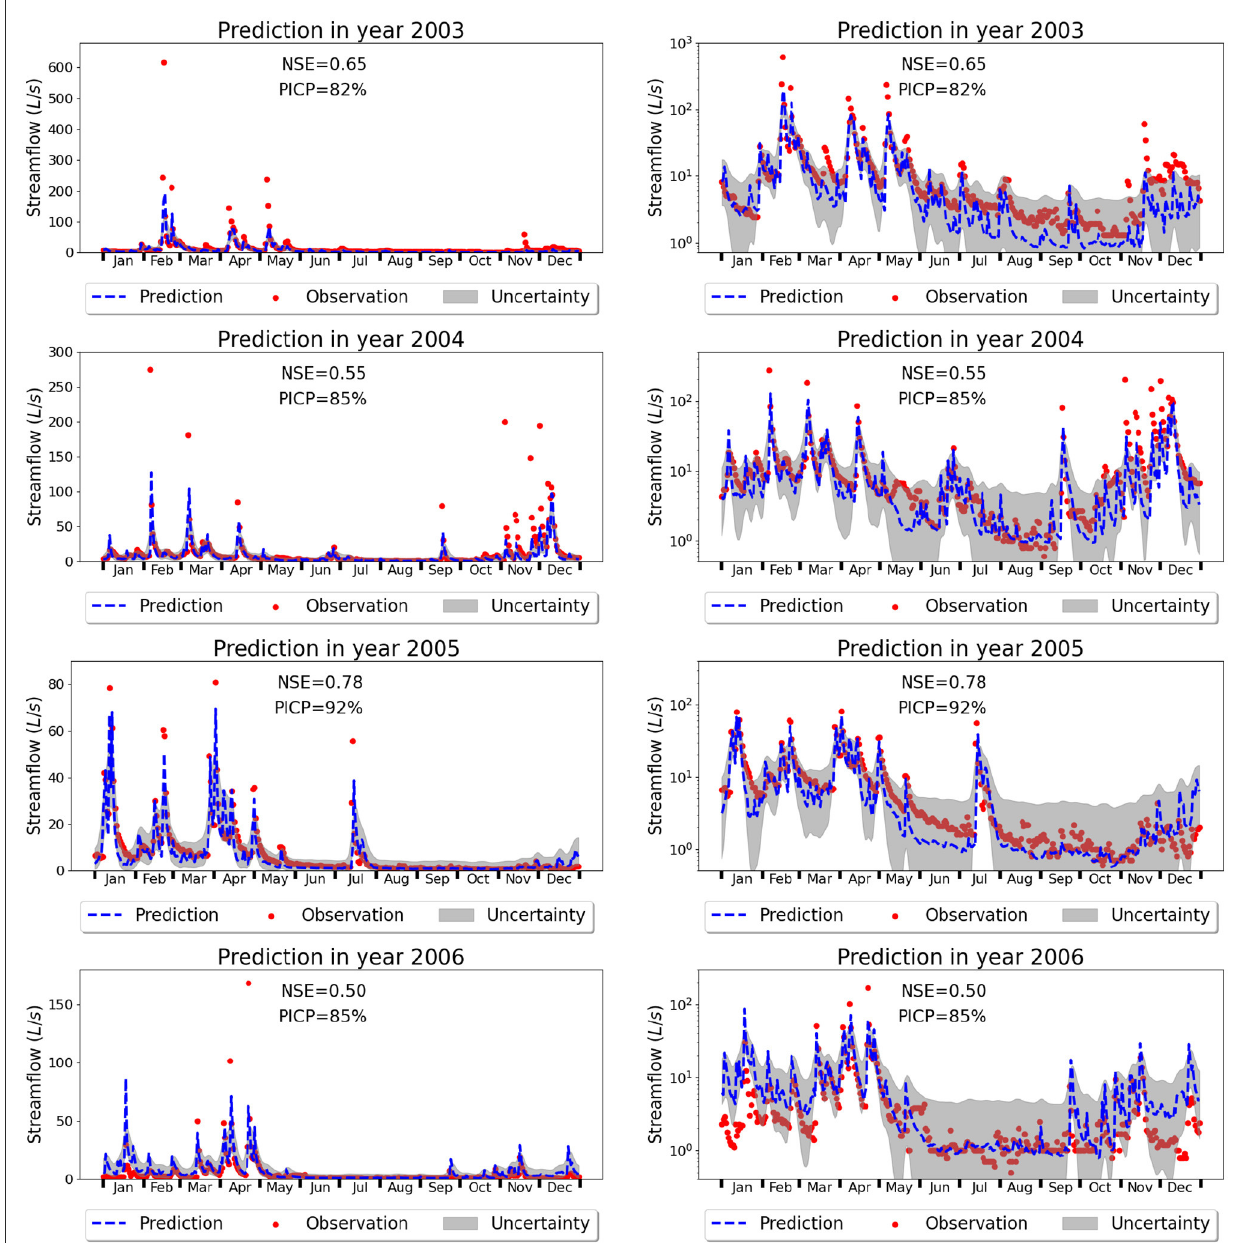
FIGURE10 Predicted (dashed blue line) and observed streamflow (red dots) in the East Fork of rain-driven WBW where the gray area quantifies the 90% prediction interval. Figures in the left column have a linear scale on the y-axes to show the underprediction of peak flows while figures on the right have a logarithmic scale on the y-axes to show the accurate prediction and predictive uncertainty of base flows. Note that the y-axis range on each figure is